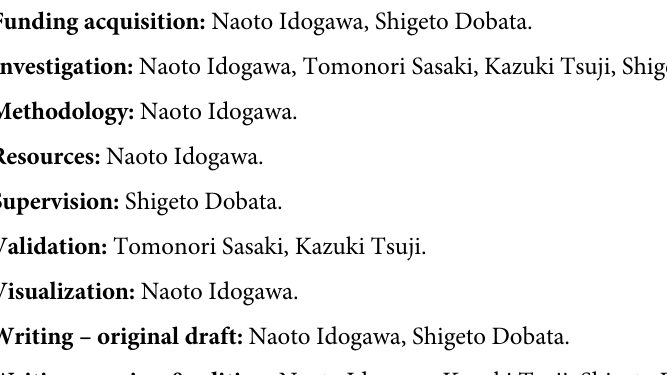
S1 Table. Microbial taxa and their relative abundances (% of total reads) per each M . tri- viale